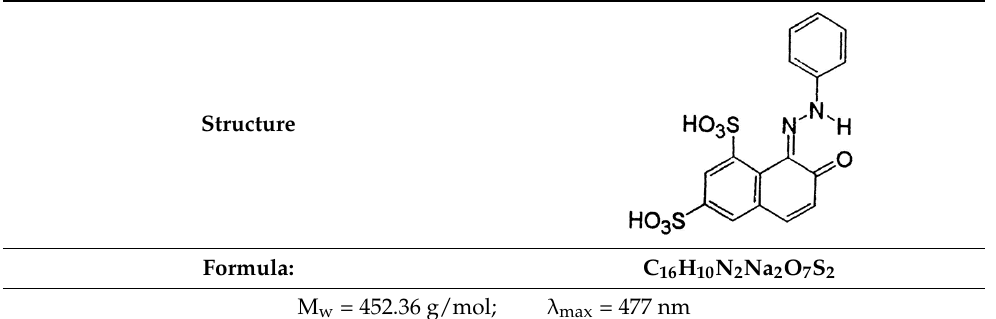
Table 1. The characteristics of acid orange 10 (AO10) dye.